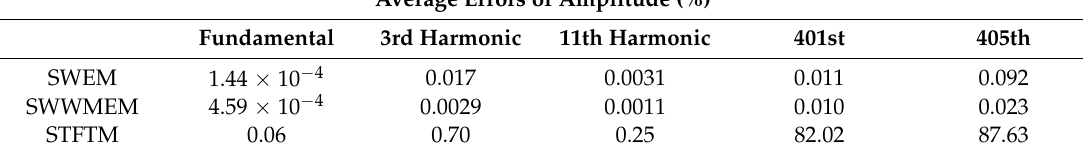
Table 1. Case study 1: ( a ) Average percentage errors of frequency; ( b ) Average percentage errors of amplitude. ( a ) Average Errors of Frequency (%) Fundamental 3rd Harmonic 11th Harmonic 401st 405th SWEM